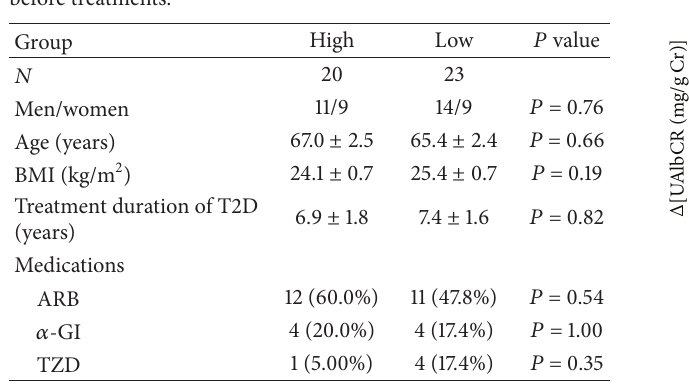
Figure 3: Δ Urinary concentrations of Alb normalized by urinary concentrations of creatinine (UAlbCR) defined by the cutoff value ofurinaryconcentrationsofangiotensinogennormalizedbyurinary concentrations of creatinine (UAGTCR) before treatment. When all patientswereredividedintotwogroups,thosewithhigherUAGTCR levels before treatment (Group H, 𝑛 = 20 ) and those with lower levels (Group L), Δ UAlbCR was significantly lower in Group H than in Group L ( −46.3 ± 32.5 versus +12.2 ± 14.9 mg/g Cr, 𝑃 = 0.0474 ).